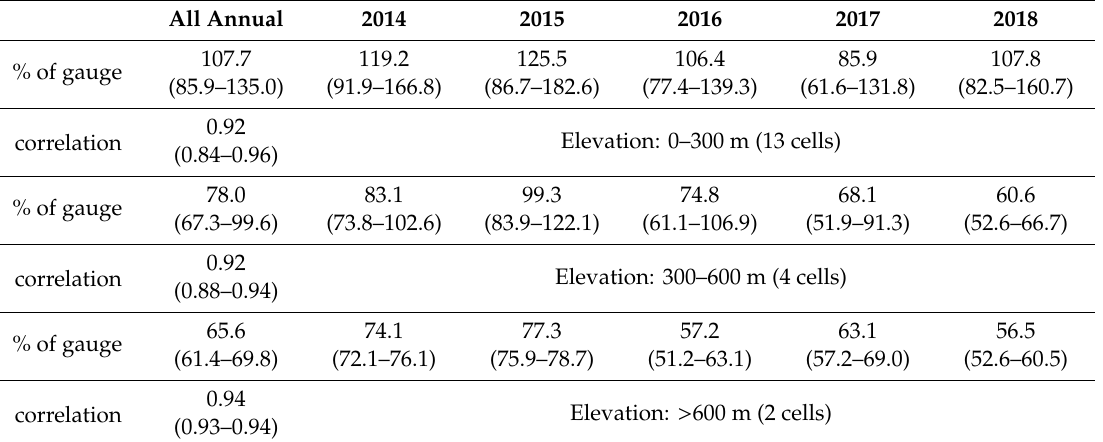
Table 6. Annual rBias and Pearson correlation coe ffi cient performance for TRMM data according to elevation (the range of values is given in parentheses).